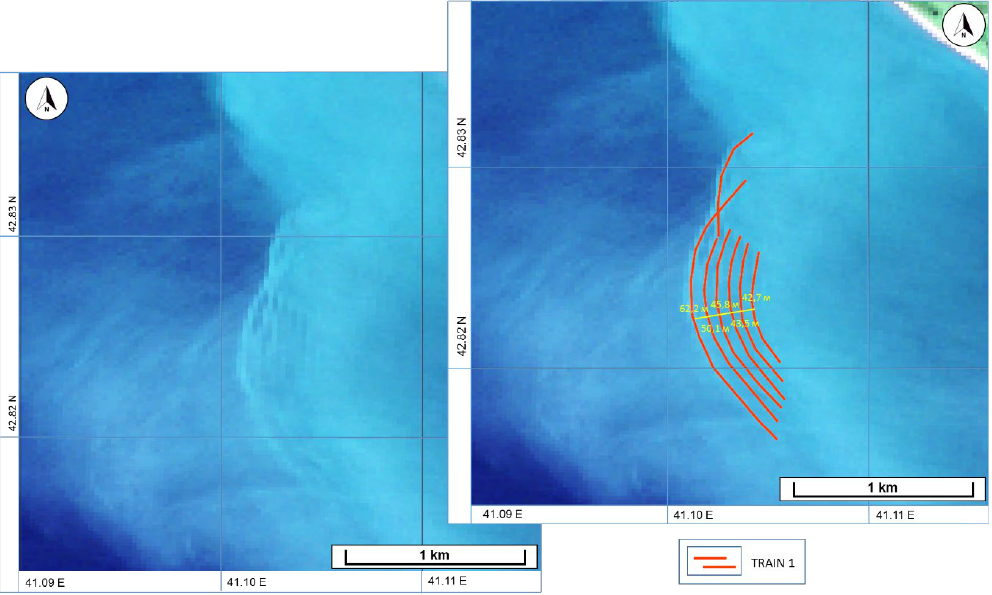
Figure 8. A train of internal waves moving from the plume of the Kodor River into the open sea (Sentinel-2, 25 August 2021).